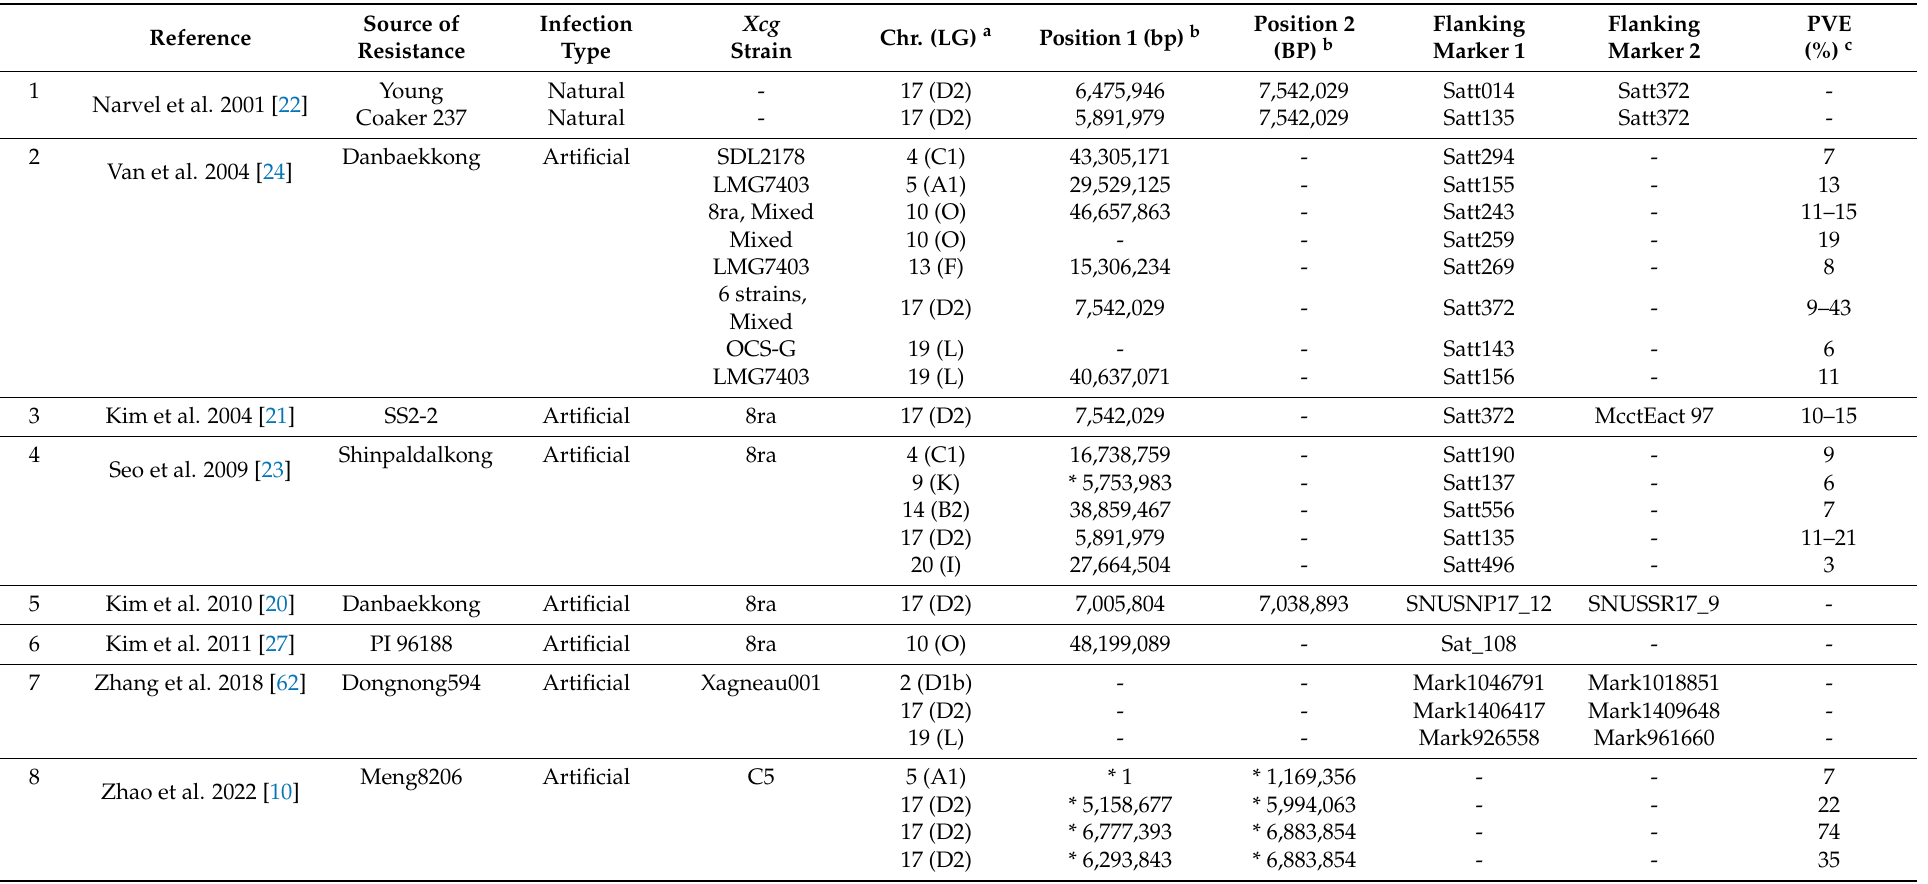
Table 1. Genomic regions associated with resistance to bacterial pustule identified by bi-parental linkage